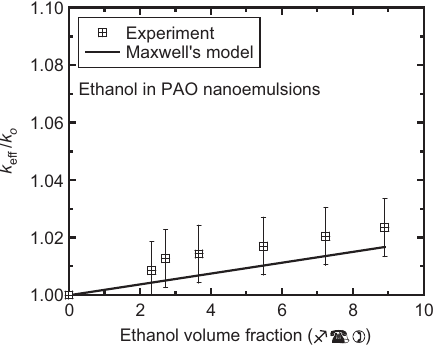
Figure 4 The relative thermal conductivity increase with the ethanol loading in the ethanol-in-PAO nanoemulsion fluids. The estimate from the Maxwell ’ s model is shown for